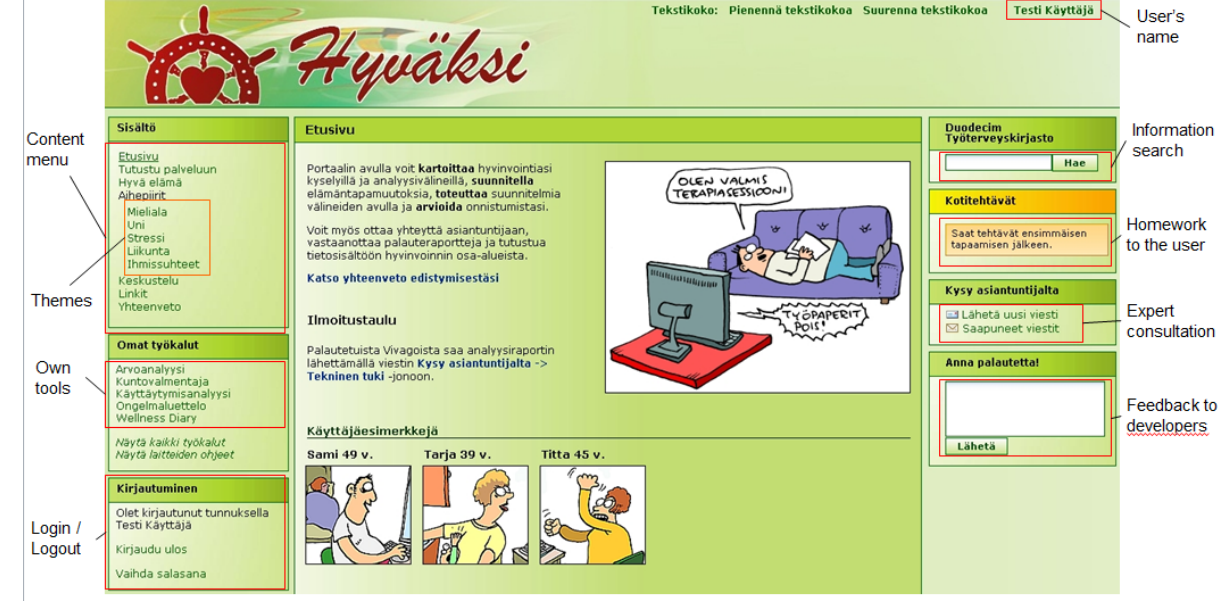
Figure 4. The main screen of the P4Well web